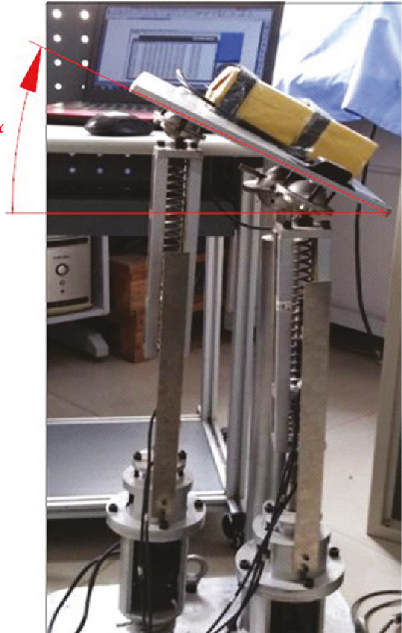
Figure 19: The experiment for a single motor drive.